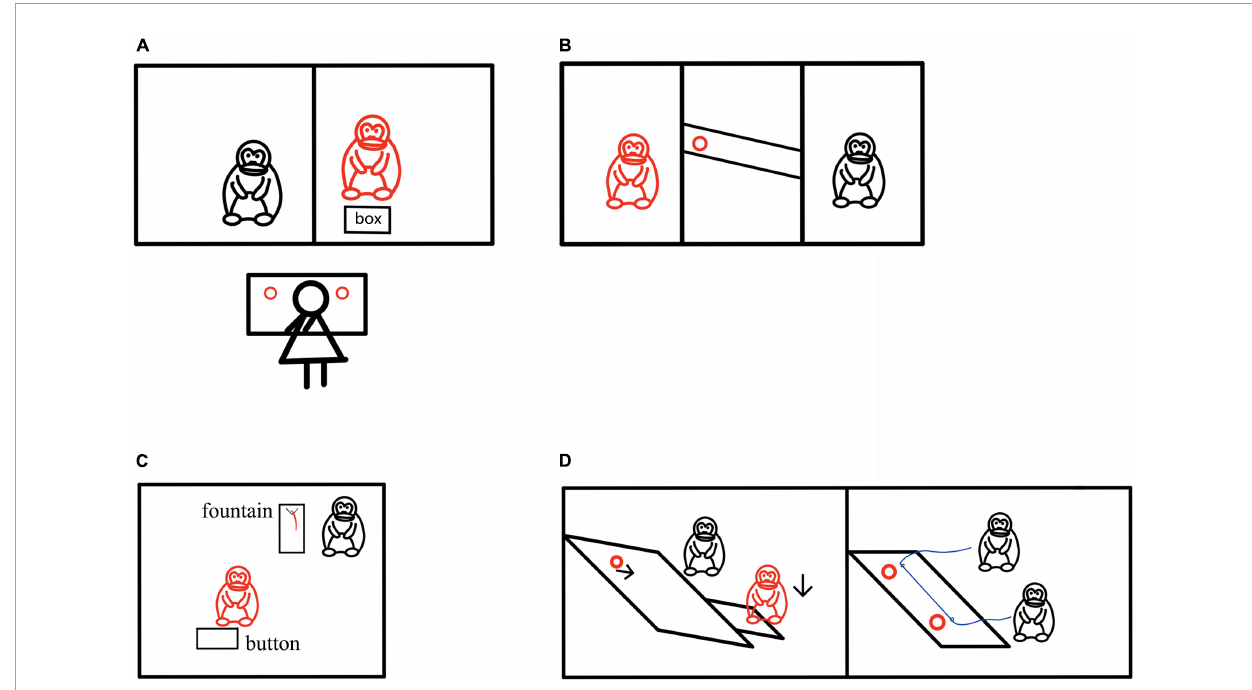
FIGURE2 Helping behavior experiments in non-human primates. (A) The red chimpanzee acted as the subject, the black chimpanzee as the companion, and figure in black was the experimenter. The red circle represented the food reward. The pro-social selection paradigm was employed where the subject was given a box of tokens that could be exchanged for food. Tokens included pro-social and pro-self tokens, with their meanings taught beforehand. Pro-social tokens resulted in rewards for both the subject and their companion, whereas pro-self tokens only yielded a reward for the subject. Results showed that chimpanzees predominantly chose pro-social tokens (Horner et al., 2011). (B) The red chimpanzee acted as the subject, and the black chimpanzee was either a friend or neutral peer. The red circle represented the food reward. The subjects were familiar with using tools to deliver food beforehand. During the test, they could choose to pull the rope to deliver food to either their friend or the neutral peer. Results showed that chimpanzees preferred to help their friends obtain food (Engelmann et al., 2019). (C) The red chimpanzee acted as the subject, and the black chimpanzee was the recipient. When the subject pressed the button, juice would flow out of a distant fountain, but only the recipient could drink it. Results showed that the majority of chimpanzees would continuously press the button (van Leeuwen et al., 2021). (D) The red marmoset acted as the subject, and the black marmoset was the recipient. The red circles represented the food reward. The altruistic paradigm on the left showed that when the subject stepped on the platform, only the black marmoset next to it received food. The cooperative paradigm on the right showed that when the red and black marmosets pulled the rope simultaneously, they could obtain food together (Martin et al.,